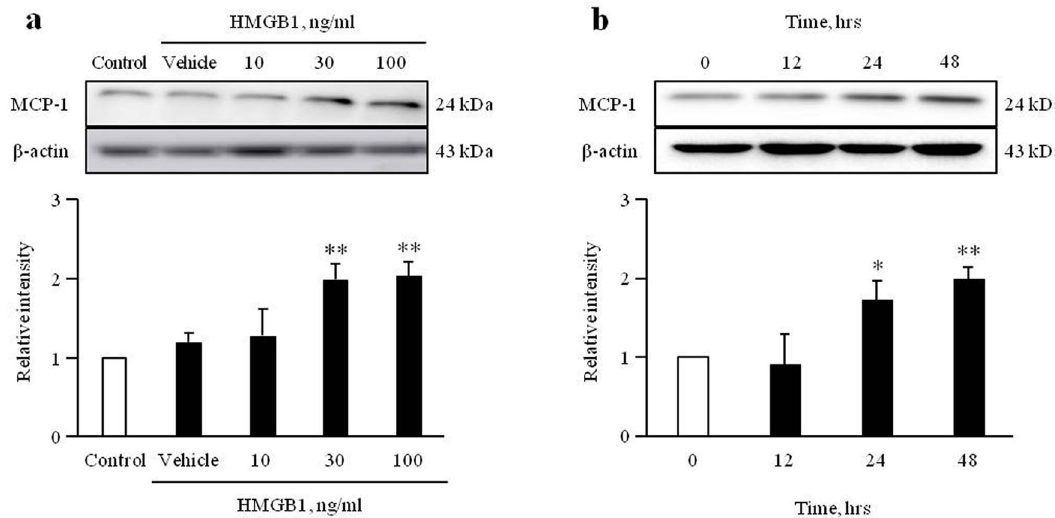
Figure 1. Role of HMGB1 on MCP-1 expression in VSMCs. Rat aortic VSMCs were treated with HMGB1 (0 to 100 ng/ml) for 48 h ( a ) or HMGB1 (30 ng/ml) for 0 to 48 h ( b ). The MCP-1 expression levels were determined by Western blotting. β-actin was used as an internal control. Relative intensities were expressed as the mean ± SEM of 3–4 independent experiments. * p < 0.05 and ** p < 0.01 vs. corresponding value in control or 0 h. Image analysis was performed using the Amersham-Imager 680, ver. 2.0. software (https:// www. cytiv alife scien ces. com/). Signal was quantified with GraphPad Prism 5, ver. 5.01. software (https:// www. graph pad. com/). Cropped gels were displayed and full-length blots/gels are presented in supplementary Fig.